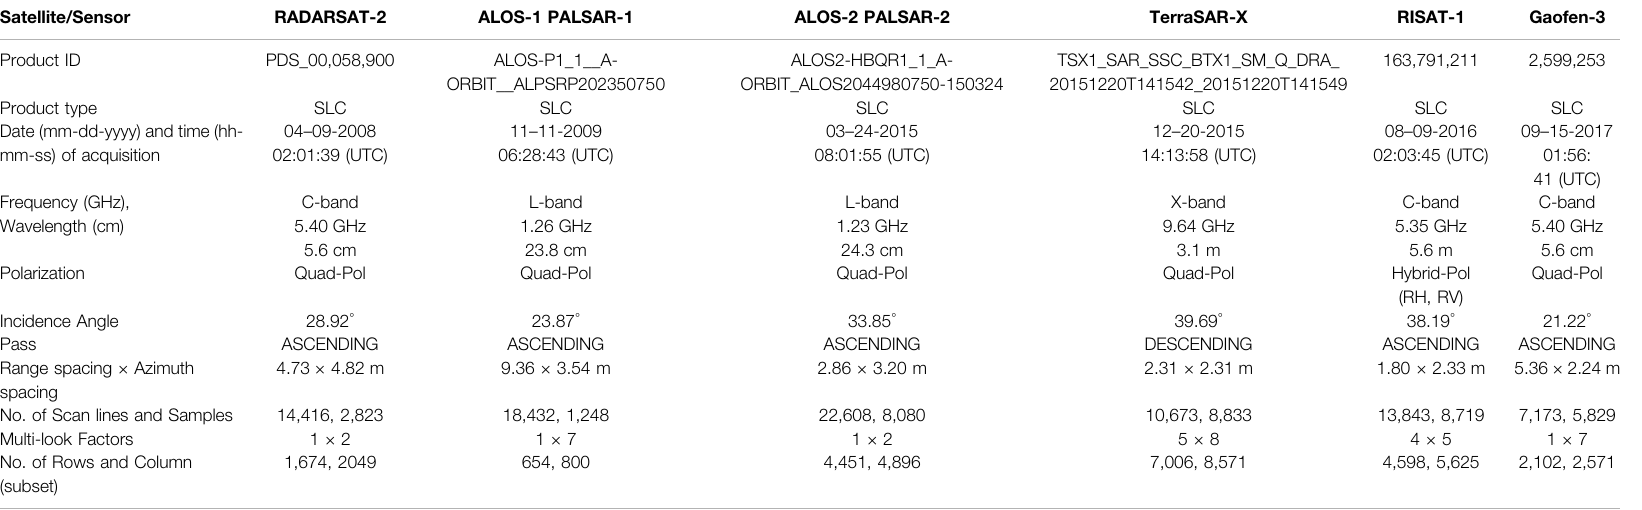
TABLE 1 | Description of datasets: SLC — single look complex; Quad-Pol — HH, HV, VH, and